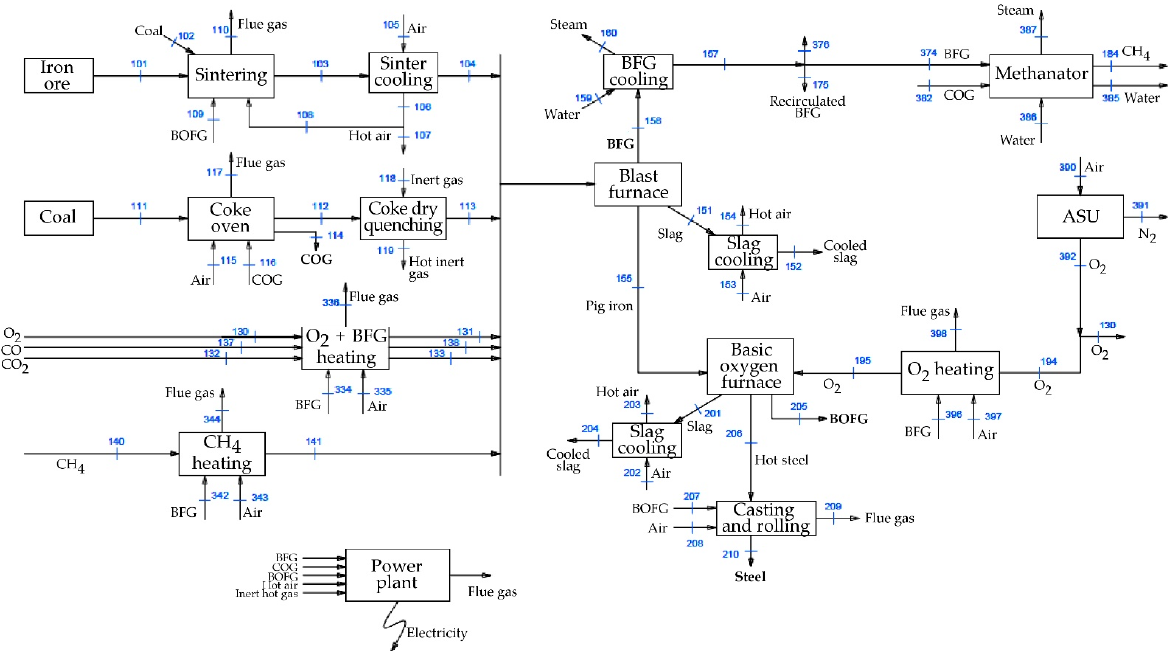
Figure 4. Block diagram of the integration of COG methanation in ironmaking with oxy-fuel combustion and TGR (Case 2).